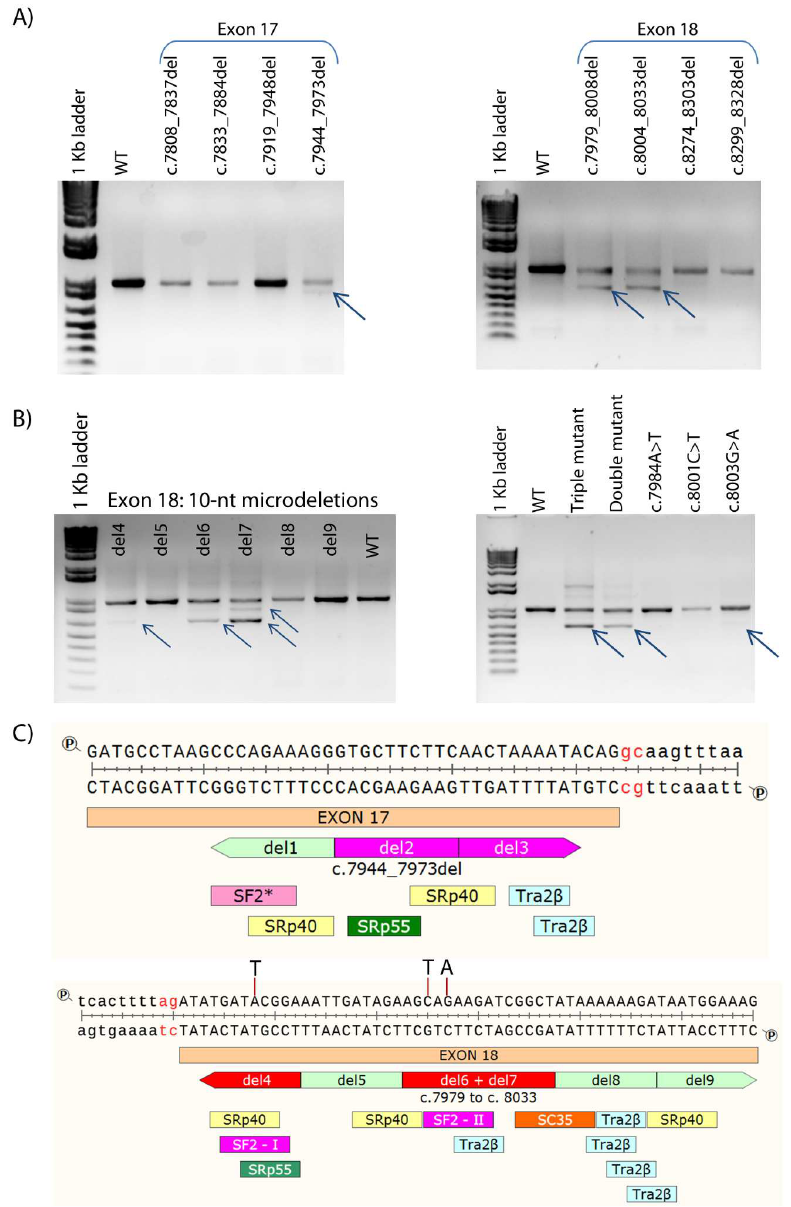
Fig 2. Map of splicing enhancers for recognition of exons 17 and 18. A) Functional mappingof ESEs of exons 17 (left) and 18 (right) by exonic microdeletions (30-nt above) of the wild type minigeneMGBR2_ex14- 20. cDNA was amplifiedwith primers of BRCA2 exon 16 (RTBR2_ex16-FW) and vector exon V2 (RTpSAD-RV; ampliconsize = 1012 nt) and run in 1.5% agarosegel. Arrows indicateabnormaltranscripts. B) Functional analysisof 10-nt microdeletions of exon 18 (left) and single nucleotide substitutions(right) c.7984A > Tthat disrupts SF2-I, and c.8001C > Tand 8003G > Athat target SF-II motif (see ESE map below). The triple mutant is the combination c.[7984A > T;8001C > T;8003G > A], and the doubleone is c. [8001C > T;8003G > A]. C) HSF predictions of putative ESE motifs of exon 17 (above) betweencDNA positions 7944 and 7973and exon 18 (below) betweencDNA positions7979–8008and 8004–8033. Intronic sequencesare in lower case. SF2 * motif of exon 17 is detected by the specific SF2/ASF (IgM- BRCA1 ) algorithmof ESEfinder. Red and pink microdeletions alter splicing.Artificial SF2- single-nucleotide substitutionsare indicatedaboveexon 18 sequence.